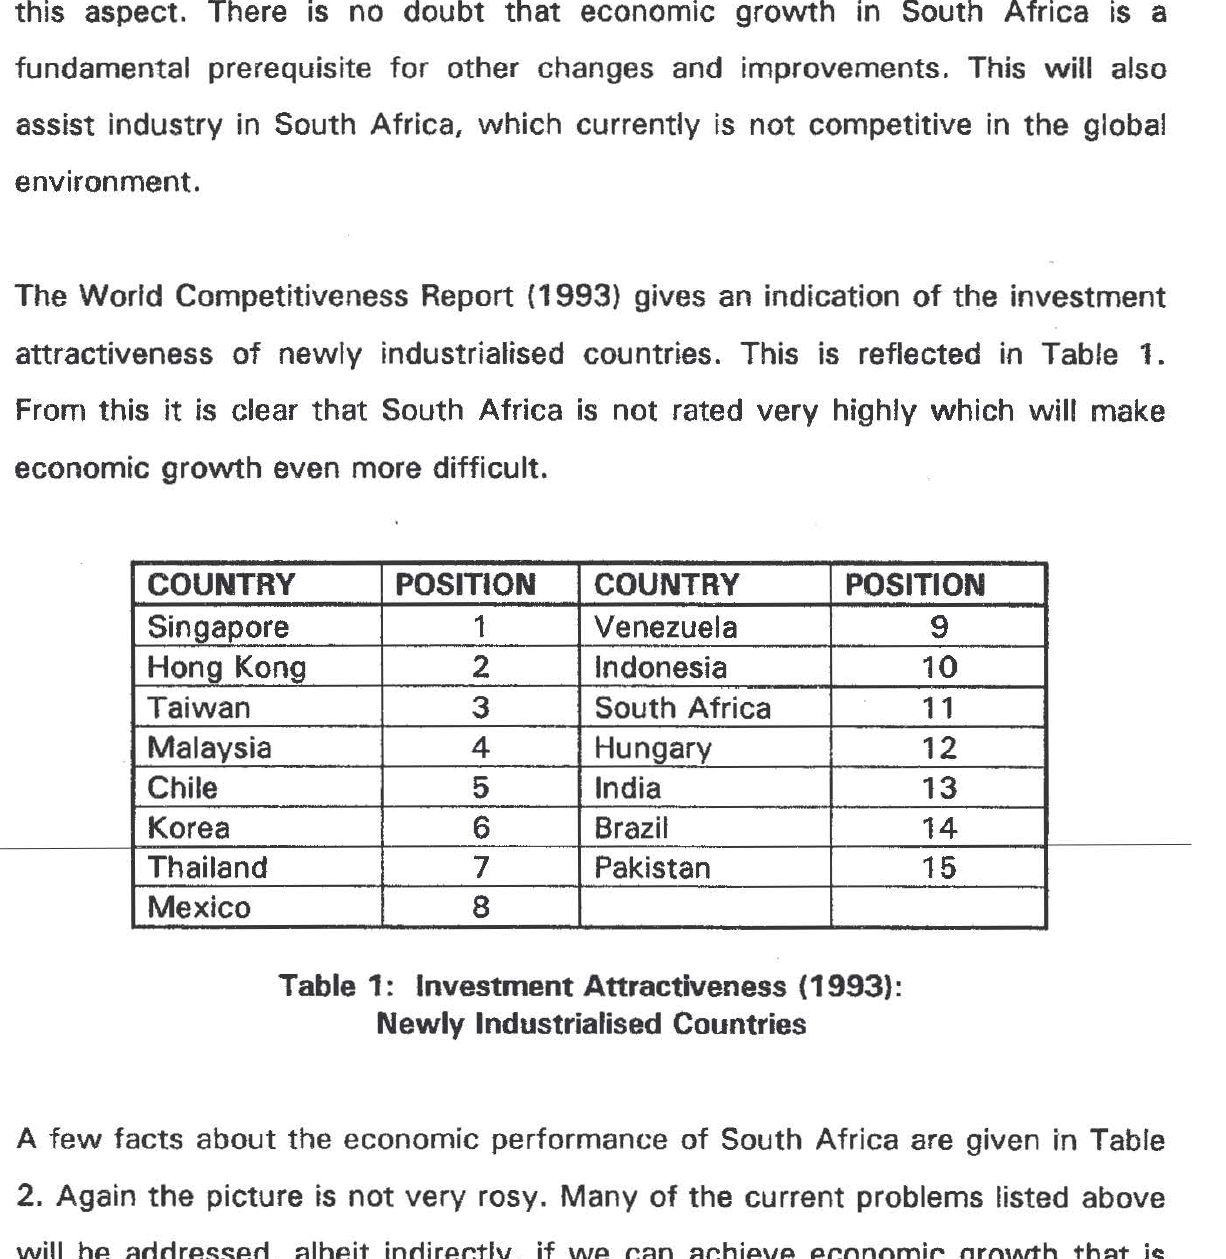
Table 1: Investment Attractiveness (1993}: Newly Industrialised